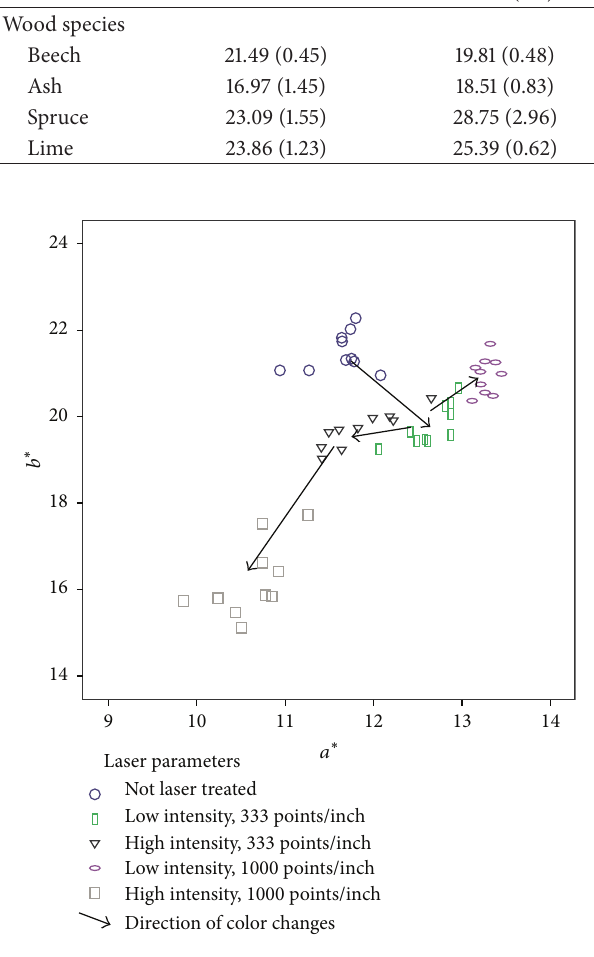
Figure 3: Influence of laser treatment on the color values ( 𝑎 ∗ and 𝑏 ∗ values) of natural beech wood surfaces.